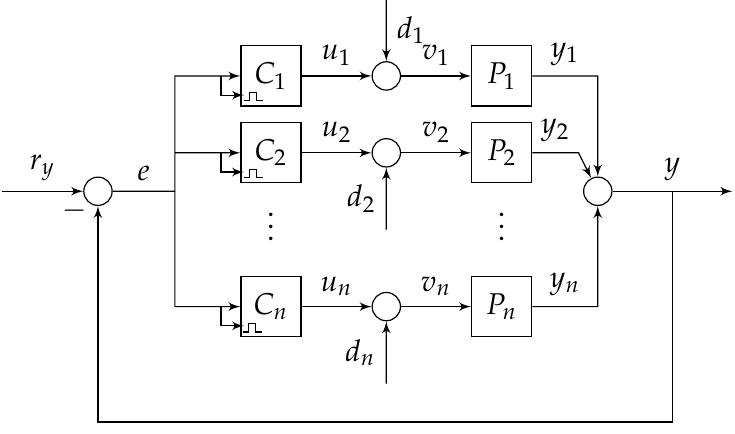
Figure 3. Block diagram of a parallel multi.input single-output (MISO) control